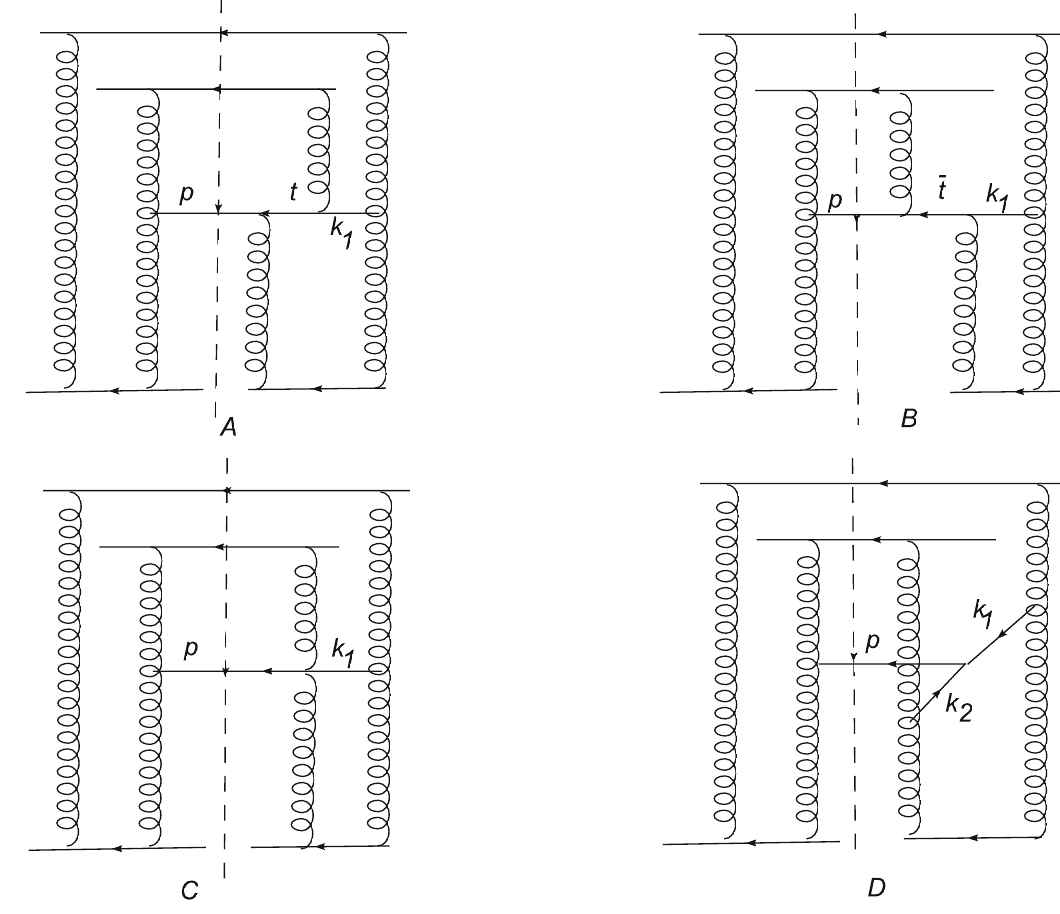
Fig. 2 Diagrams containing vertex parts (cid:9) i , i = 1 ,..., 5. (cid:9) 1 , 2 , 5 correspond to A, B and D. (cid:9) 3 , 4 correspond to